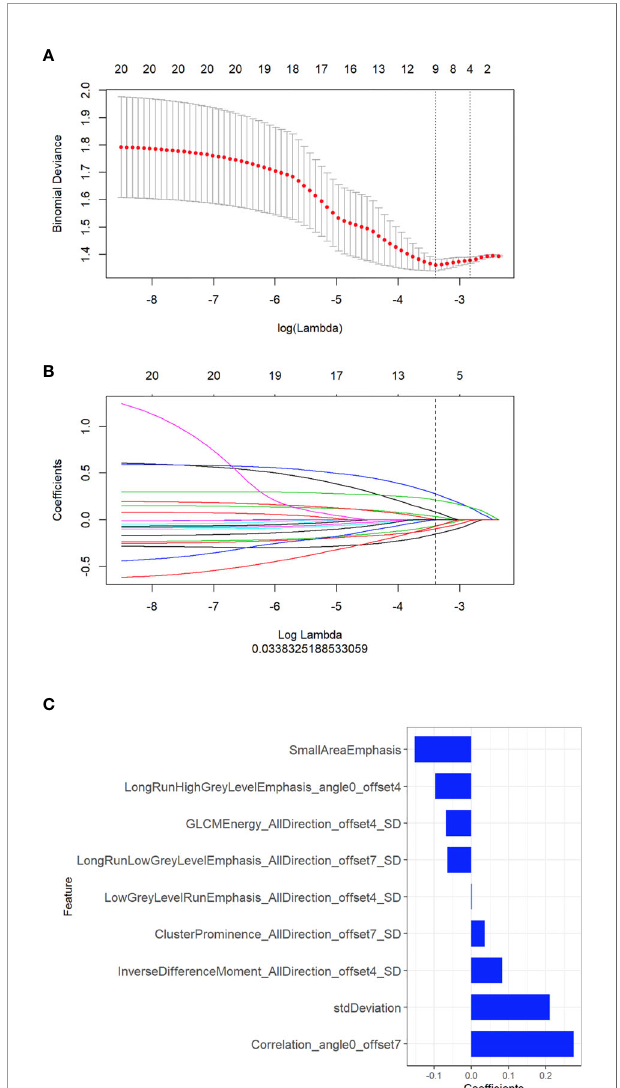
FIGURE 1 | Selection of radiomic features associated with EGFR-activating mutations using the LASSO regression model. (A) Cross-validation curve. An optimal log lambda (0.03) was selected, and 9 non-zero coef fi cients were chosen. (B) LASSO coef fi cient pro fi les of the 396 radiomic features against the deviance explained. (C) Histogram showing the contribution of the selected parameters with their regression coef fi cients in the signature